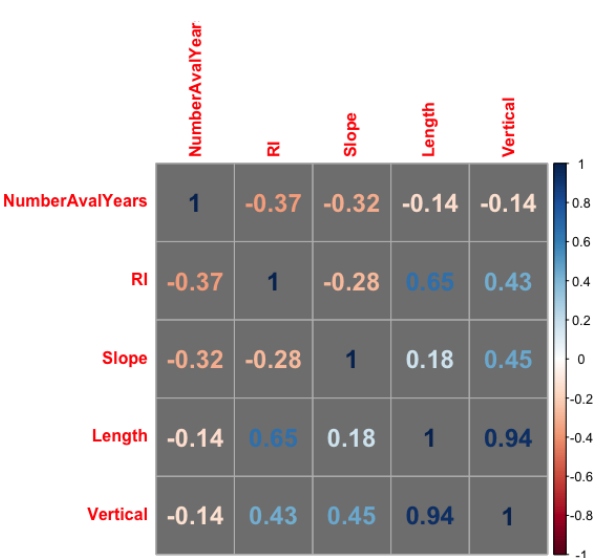
Figure A1. Correlation matrix (Pearson correlation coefficients) of the number of avalanche years, return interval (RI), starting zone slope angle (Slope), and path length (Length). Statistical significance is p < 0 . 05. See source data in Table